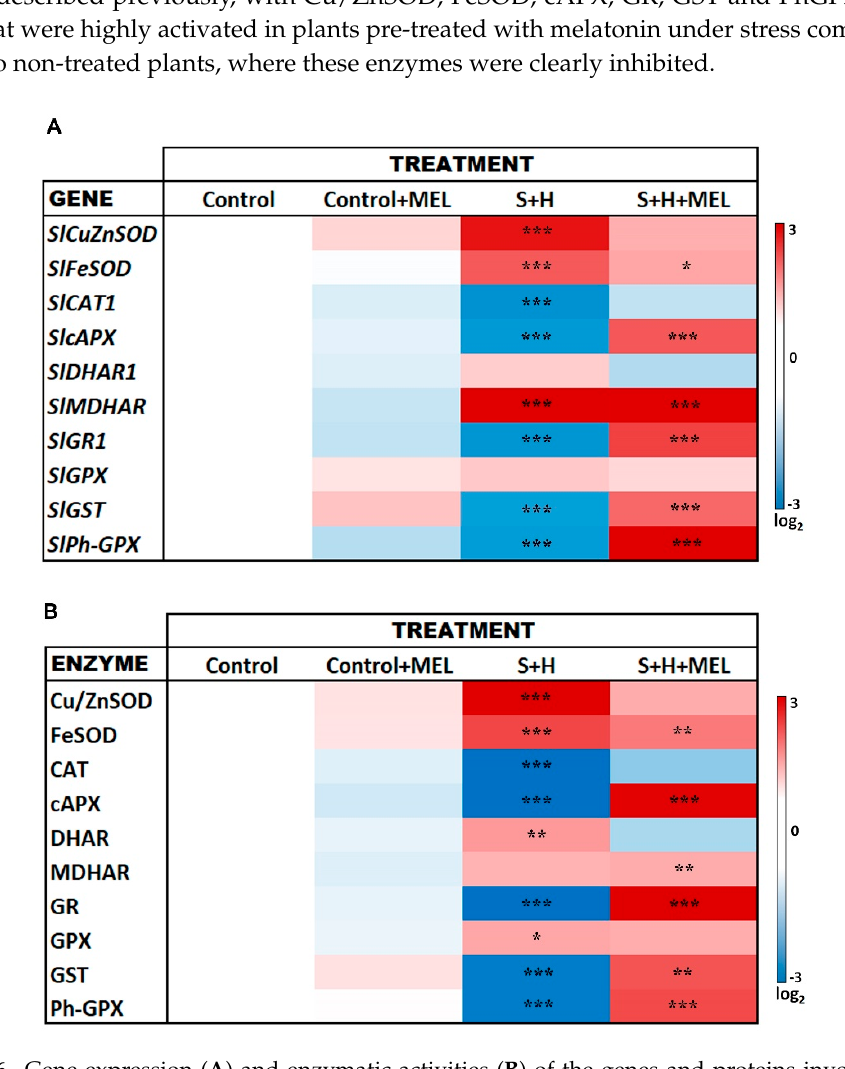
Figure 6. Gene expression ( A ) and enzymatic activities ( B ) of the genes and proteins involved in the oxidative metabolism in tomato plants treated and non-treated with melatonin under control or stress combination. Red color represents a higher relative expression or activity with respect to control plants and blue color represents a lower relative expression or activity. Scale is the log 2 values of the expression after normalization with respect to control plants. Absolute values (gene expression and enzymatic activities) as well as log 2 values can be found in Supporting Information Tables S2–S5, respectively. Asterisks are representative of significant differences with respect to control plants (* p < 0.05, ** p < 0.01, *** p < 0.005).